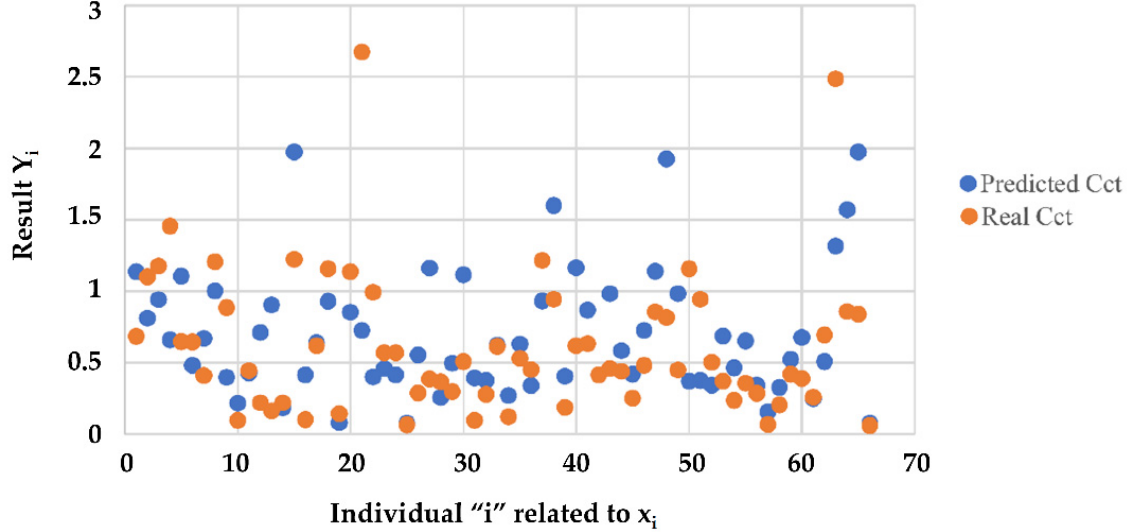
Figure 8. Coefficient C ct : prediction results.